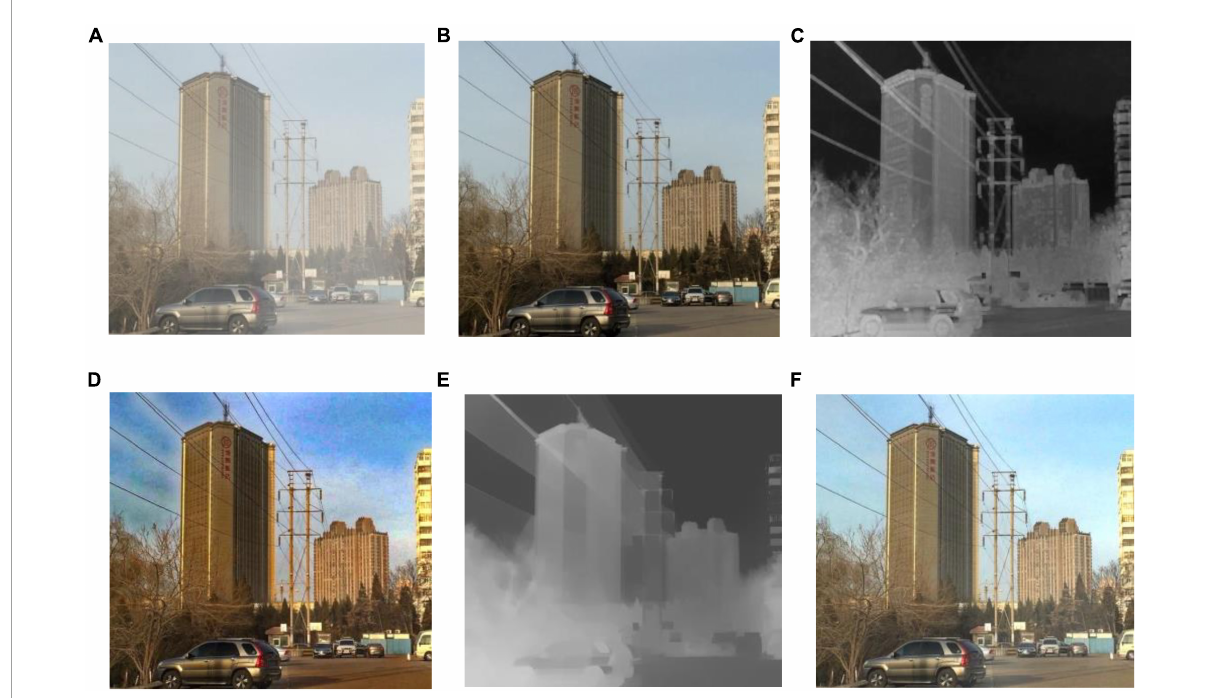
FIGURE6 The effect of this method on transmission line transmittance optimization. (A) Hazy image; (B) ground truth (C) transmission of dark channel prior; (D) result of dark channel prior; (E) transmission of our method; (F) preliminary result of our